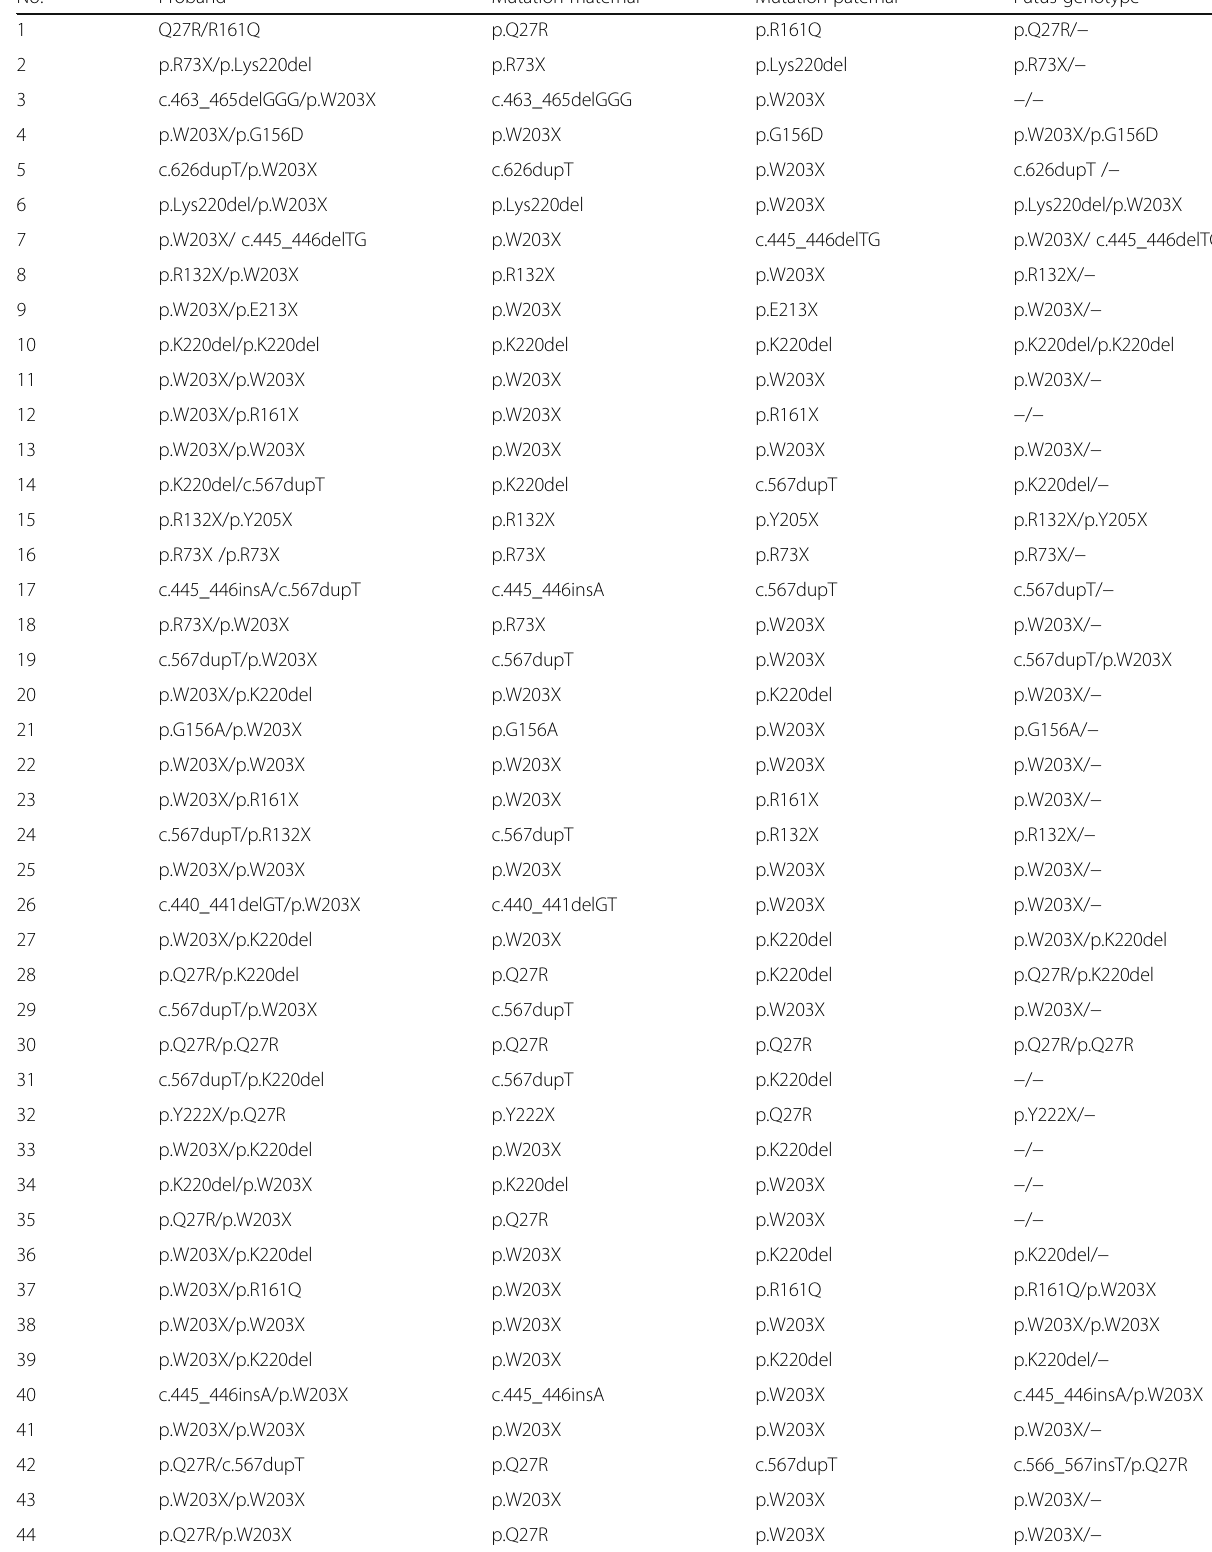
Table 2 The genotypes of 62 pedigrees who have performed the prenatal genetic diagnosis